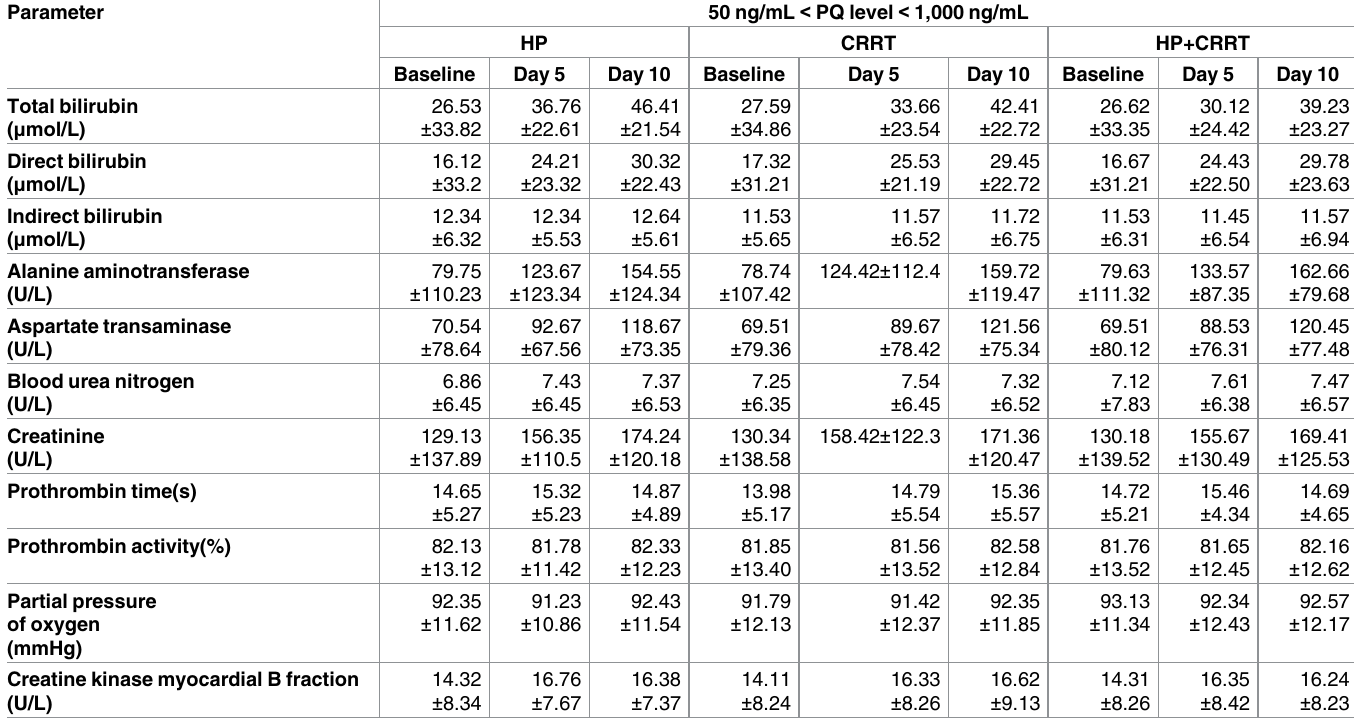
parameters between the groups. The 81 patients with plasma PQ levels of 1000–5000 ng/mL exhibited comparable biochemical parameters, with the exception of survival or improvement, Table 2. Blood biochemical parameters of patients with low plasma paraquat (PQ) levels over time (n = 83).